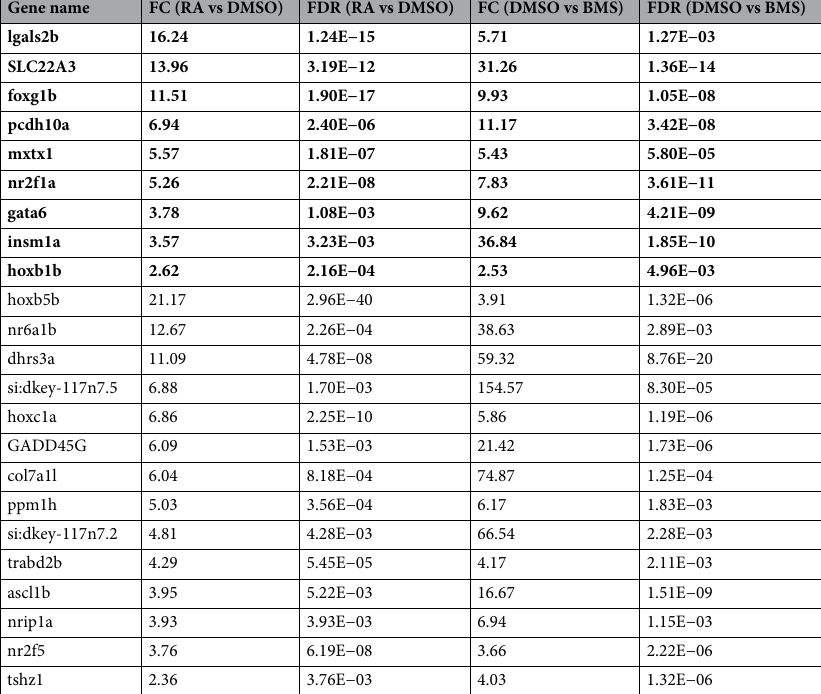
Discovery Rate (FDR) for the RA treatment (column 2 and 3) and for the BMS493 treatment (columns 4 and 5). The genes highlighted in bold are those showing enriched expression in endoderm (FC > 4 and FDR <